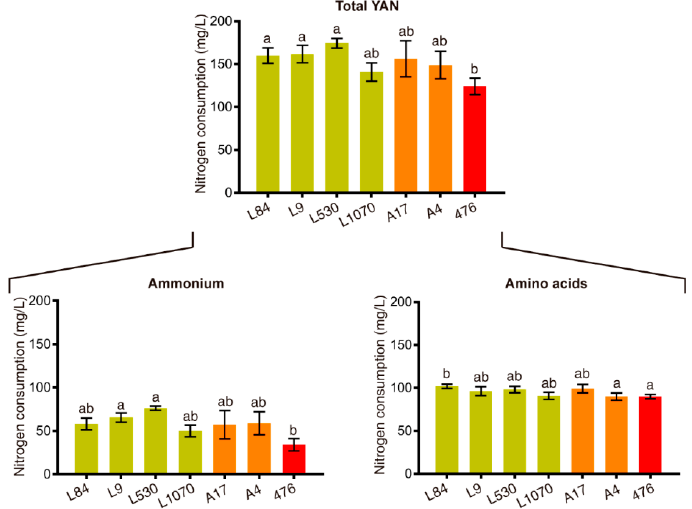
Figure 1. YAN consumption of improved strain “476” and their parental strains. Consumption of nitrogen sources are shown for improved strain “476” (red bar) and their respective F 1 “parents” (A17 and A4) (orange bars) and F 0 “grandparents” (L84, L9, L530 and L1070) (dark-yellow bars). Statistical analysis for each nitrogen source consisted in independent ANOVA followed by Tukey’s tests, with values that have a statistically significant difference ( p -value < 0.05) having different superscript letters (a and b). Plotted values correspond to three biological replicates average, with error bars representing their standard error (mean ± SEM).